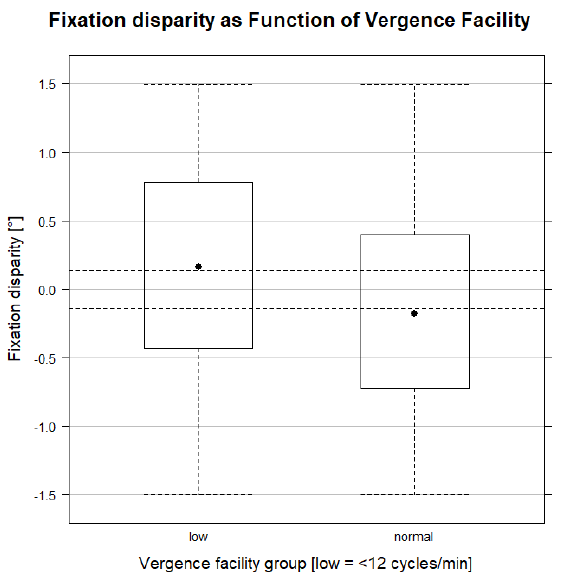
Figure 1: dashed lines indicate +/- ½ character space (+/- 0.14°) distance between intersection points of fixation lines in the target